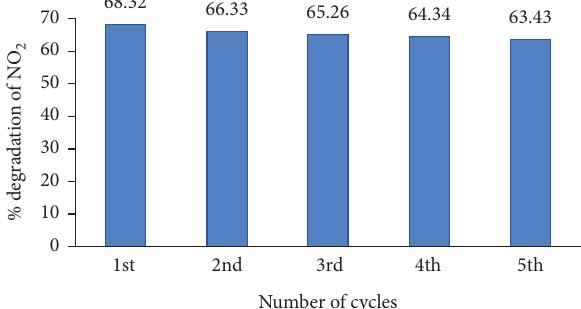
Figure 6: Ambient concentration of NO